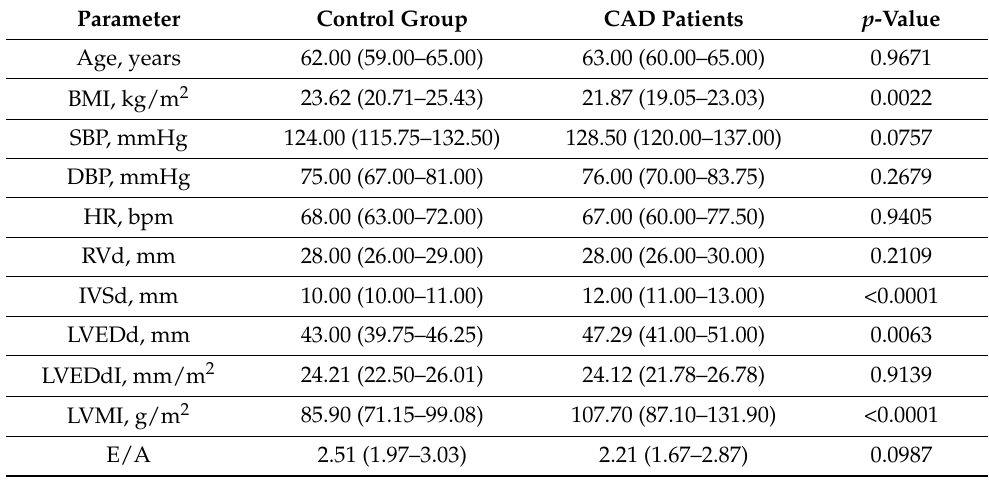
Table 1. Comparisons of continuous data between control subjects and CAD patients (median (IQR)) (Mann–Whitney test).